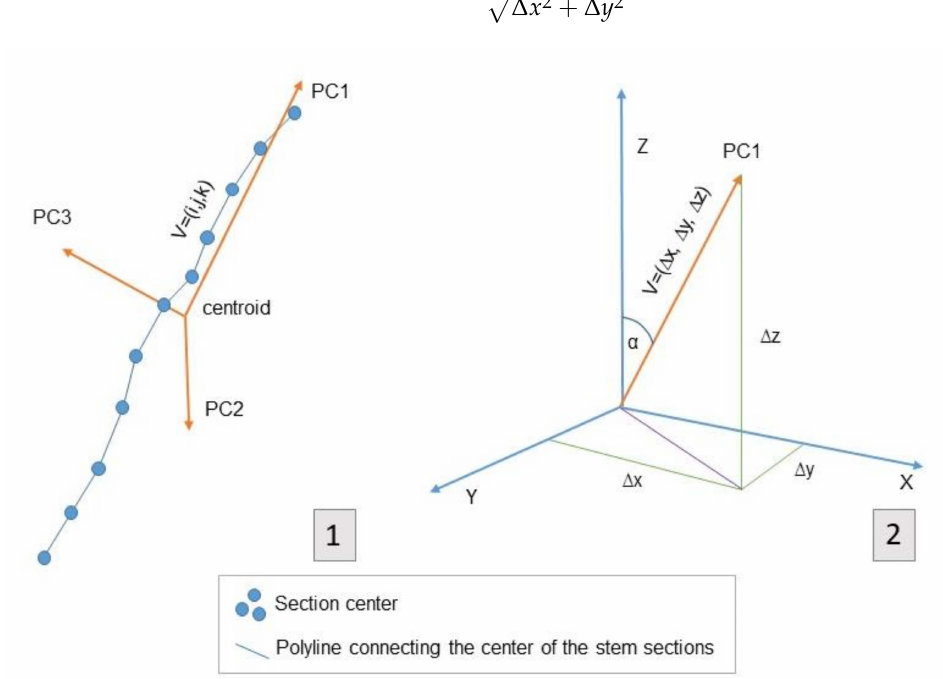
Figure 5. ( 1 ) Coordinate axis resulting from PCA analysis applied to the stem section centers. ( 2 ) Calculation of lean angle ( α ) from PC1 with respect to the